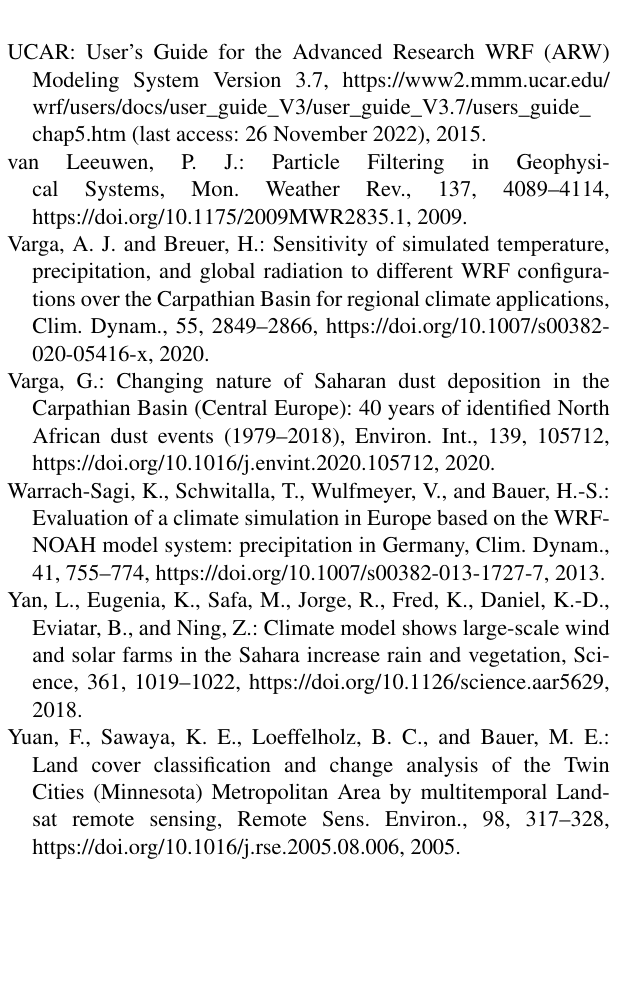
Tabari, H.: Climate change impact on flood and extreme precipita- tion increases with water availability, Sci. Rep.-UK, 10,